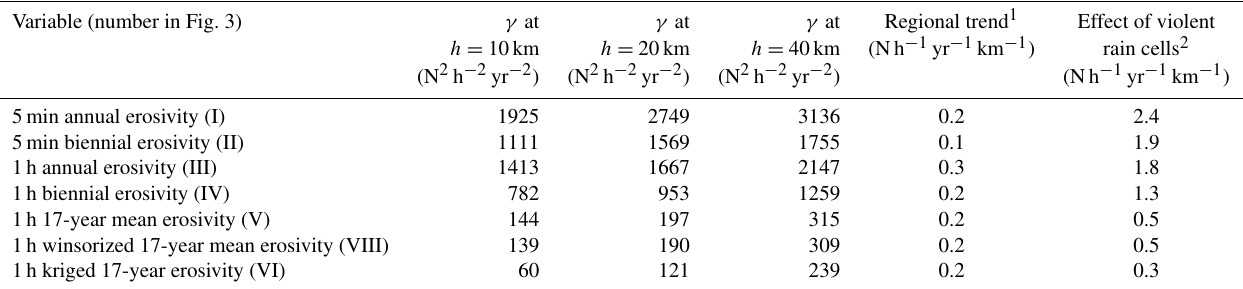
Table 1. Influence of temporal resolution of rain data (5min and 1h), averaging (1, 2, and 17 years), winsorizing and kriging on the semivariance ( γ ) at three distances h . For complete semivariograms see Fig. 3a. Variable (number in Fig. 3)